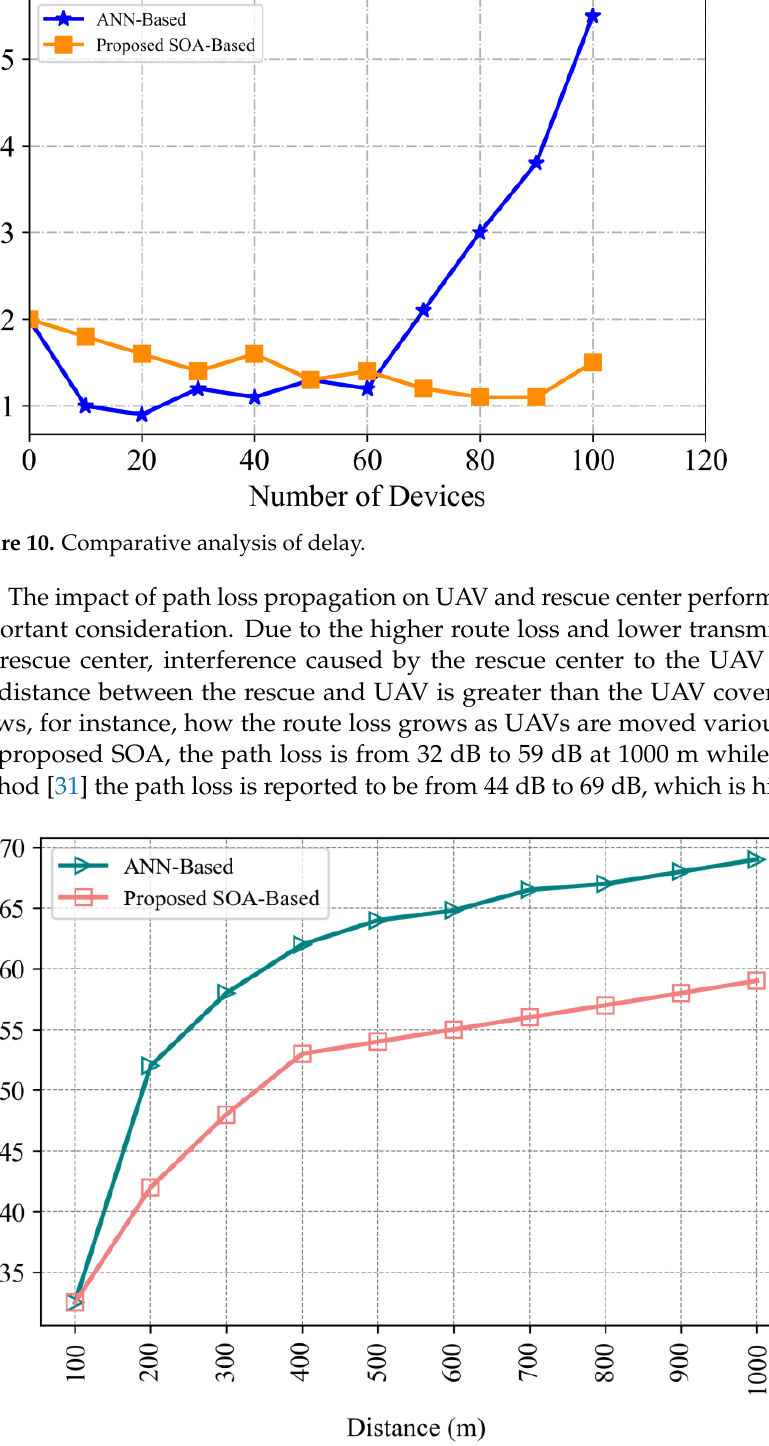
Figure 9. Comparative analysis of throughput.